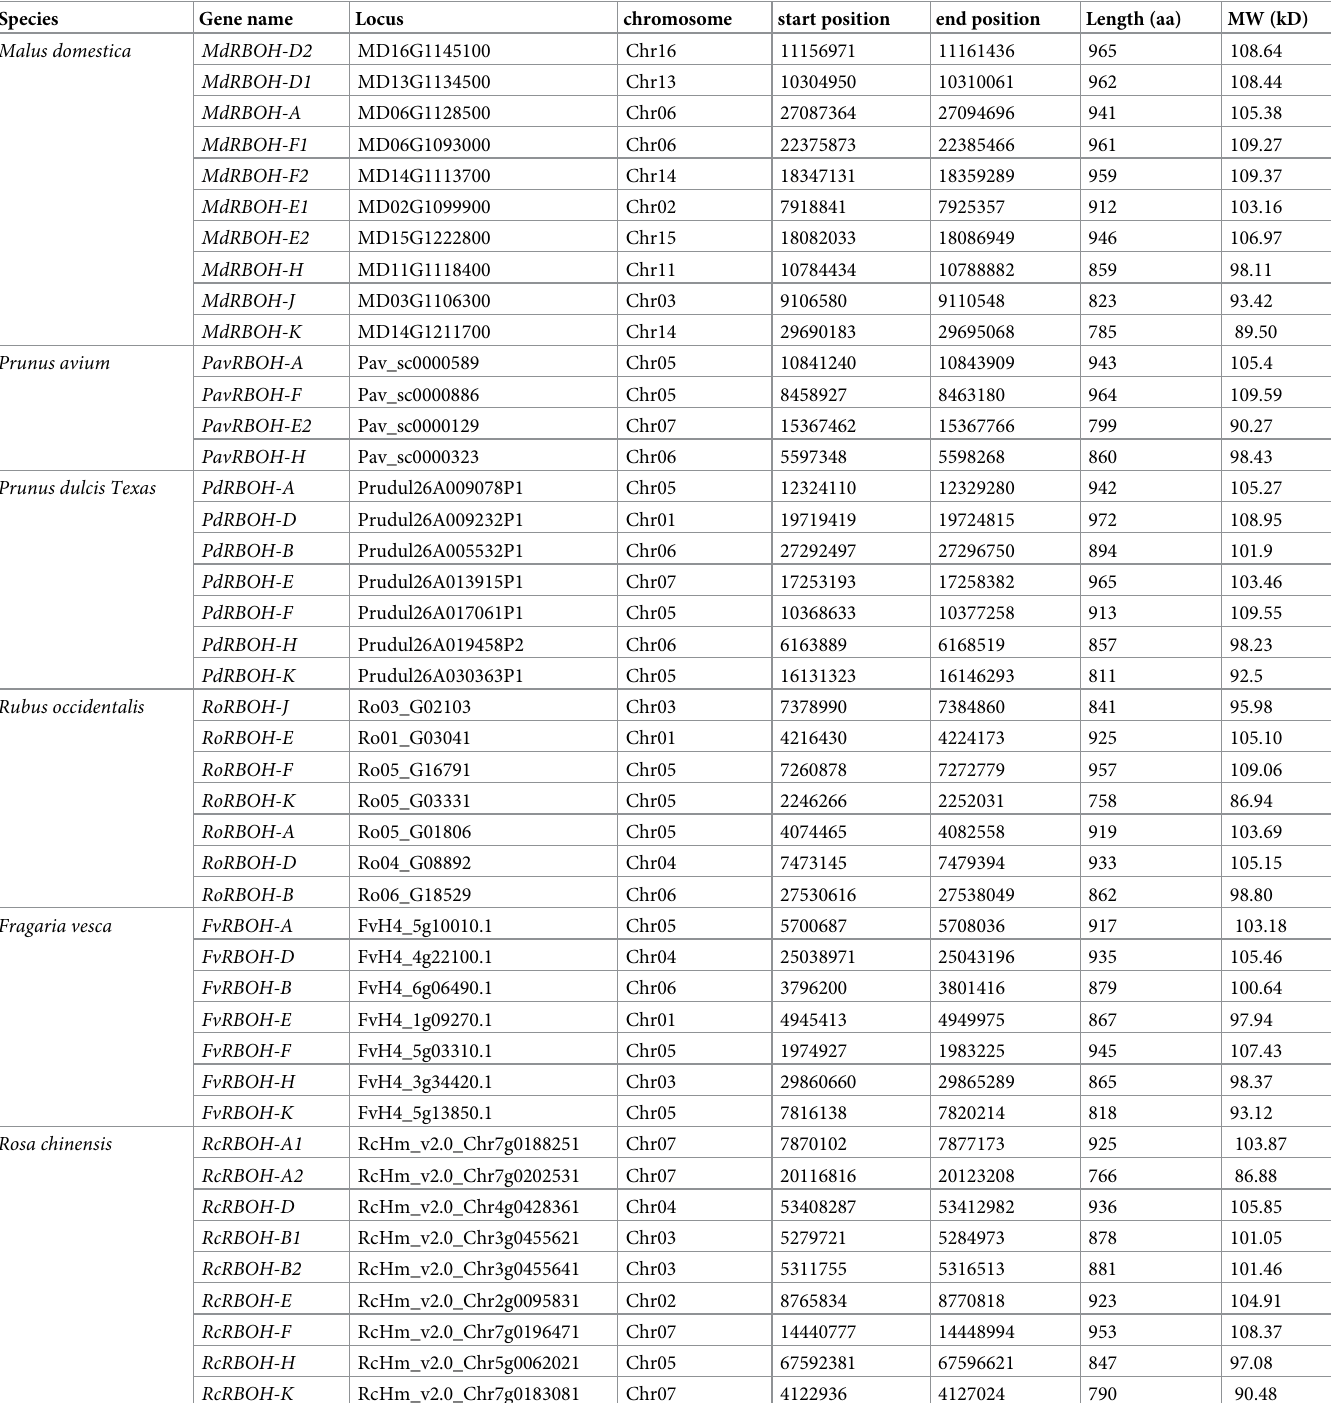
Table 1. RBOH genes identified in this study. Subcellular localization predications indicated that the ROBHs were all located in the cell membrane.